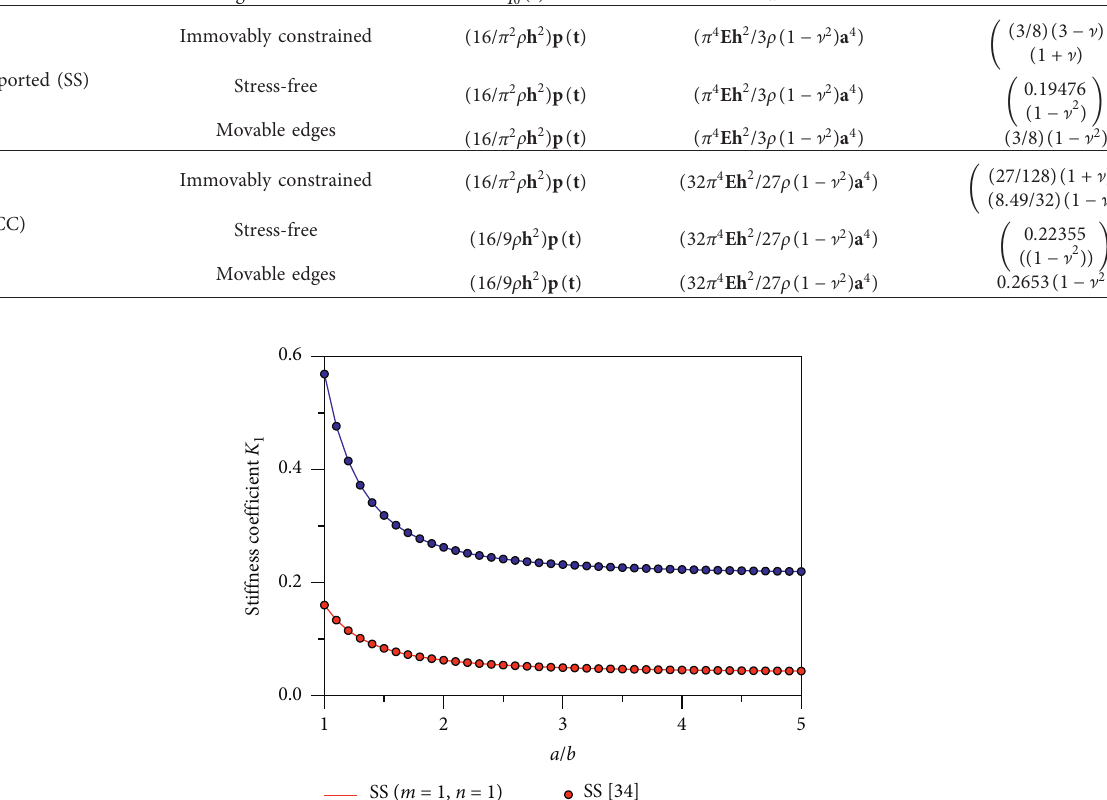
Table 1: Derivation of the governing parameters for SS or CC square plates, based on the SDOF model herein developed. Boundary condition Simply supported (SS)